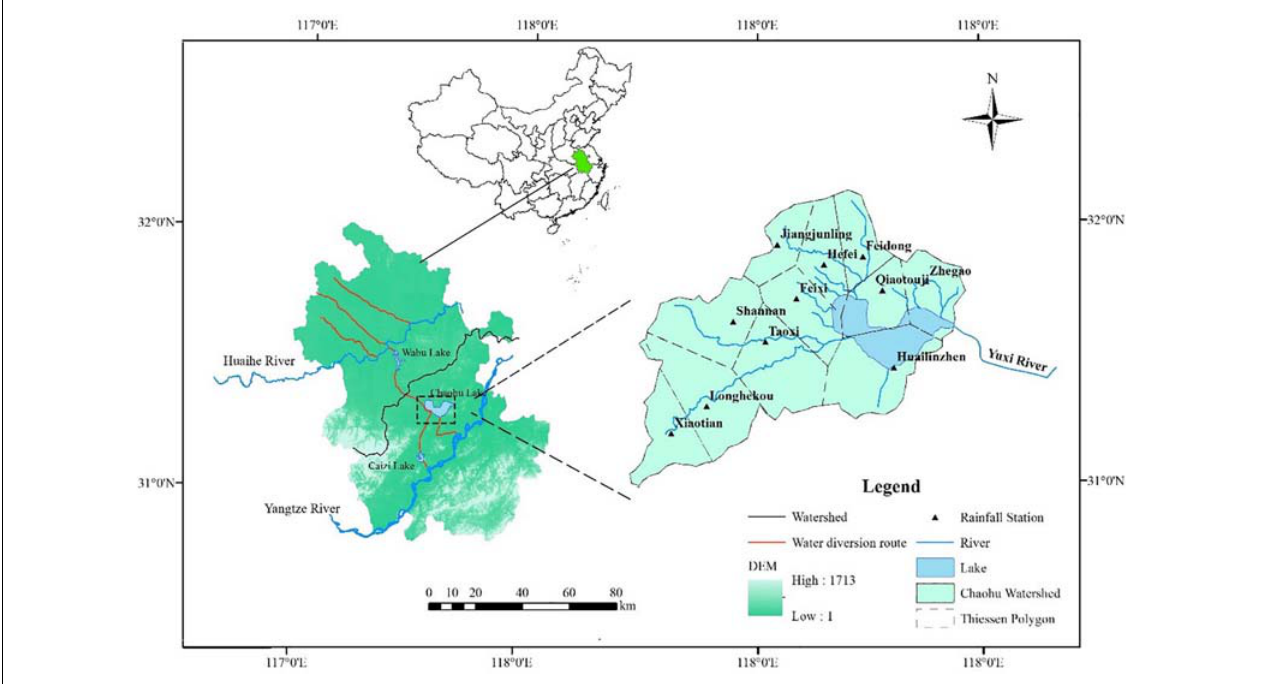
FIGURE 1 | Location map for study and gauge